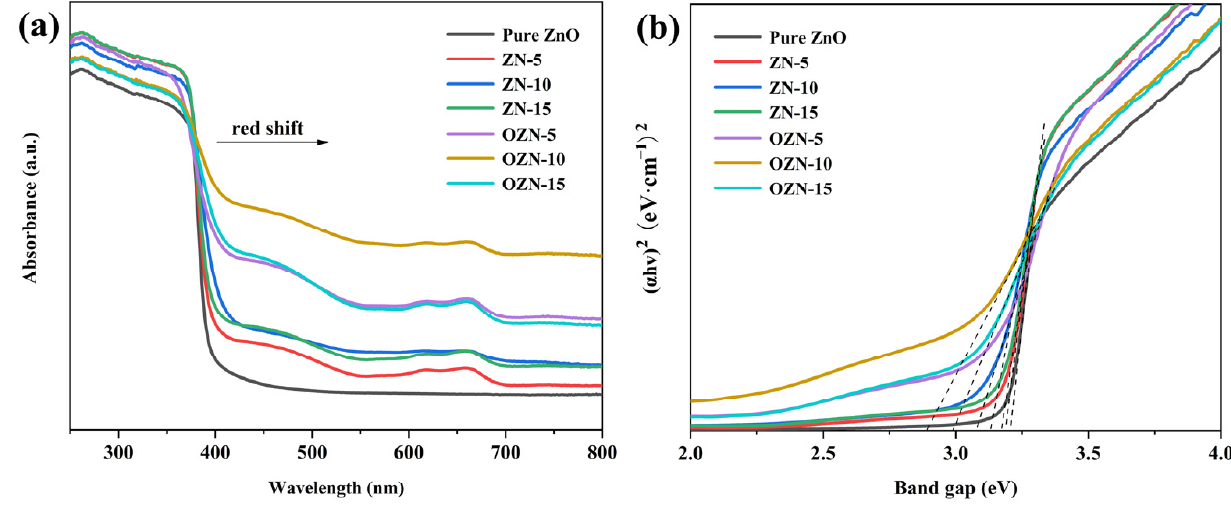
Figure 7. ( a ) UV-Vis absorption spectra and ( b ) band gap energy of ZnO, ZN and OZN. Photoluminescence spectroscopy is an effective method to study the electronic